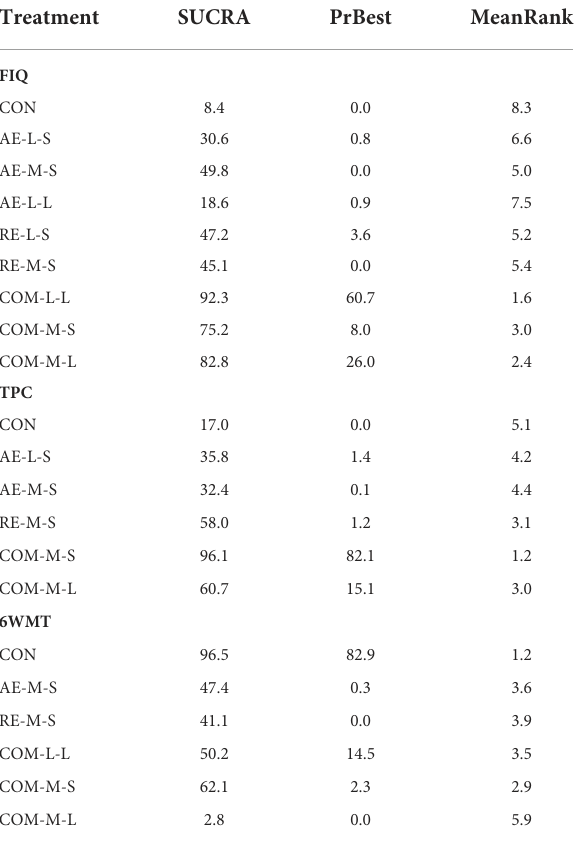
TABLE 6 Relative ranking of exercise programs for treatment. Figure 8 for a forest plot). Most of the data analyzed came